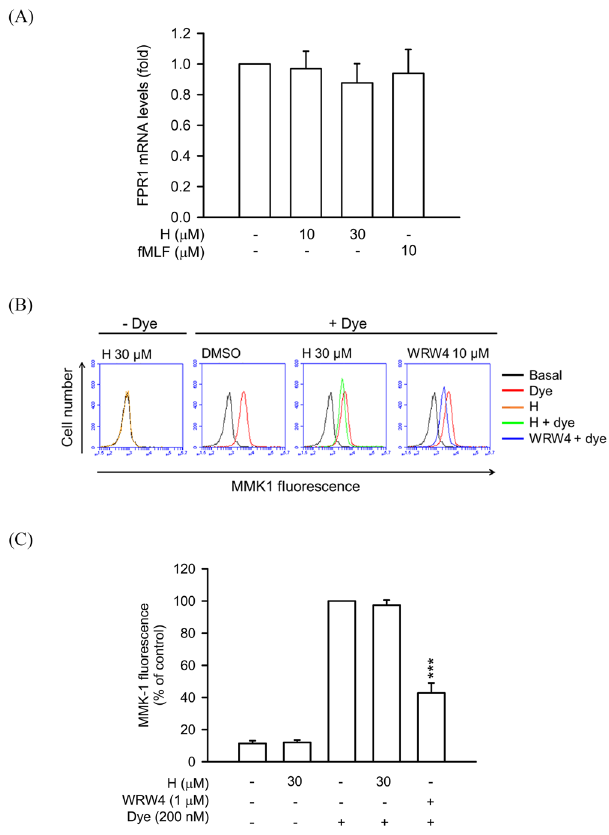
Figure 6. Honokiol does not alter FPR1 mRNA expression and FPR2 binding effect in human neutrophils. ( A ) Human neutrophils were treated with 0.1% DMSO (as control), honokiol (10 and 30 μ M), or fMLF (10 μ M) at 4 °C for 30 min. Total RNAs were isolated with Trizol reagent and FPR1 mRNA levels were analyzed by quantitative PCR. ( B ) Human neutrophils were incubated with 0.1% DMSO (as control), honokiol (H; 10 μ M), or WRW4 (1 μ M) for 10 min and then labelled with FPR2-specific fluorescent ligand MMK-1F (200 nM) for 15 min. Representative histograms showing typical fluorescence in the absence or presence of MMK-1F with honokiol or WRW4. ( C ) Mean fluorescence intensity of ( B ) is shown. All data are expressed as the mean ± S.E.M. ( n = 3 or 4). *** P < 0.001 compared with fluorescent dye